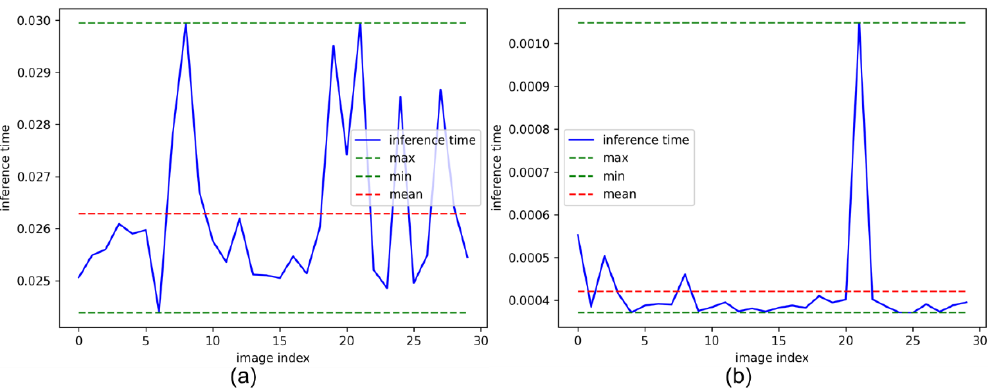
Figure A8. The timing curves of the proposed NI-U-Net and the classical method (OTSU segmentation) using the 30 evaluation scenes. ( a ) refers to the inference timing curves of the proposed NI-U-Net, and ( b ) refers to the operation timing curves of the OTSU method. The mean for ( a ) is 0.02549 s per frame (the red dash line in ( a )), while ( b ) is 0.00041 s per frame (the red dash line in ( b )). The OTSU algorithm is implemented using the “cv2.THRESH_OTSU” of OpenCV library.